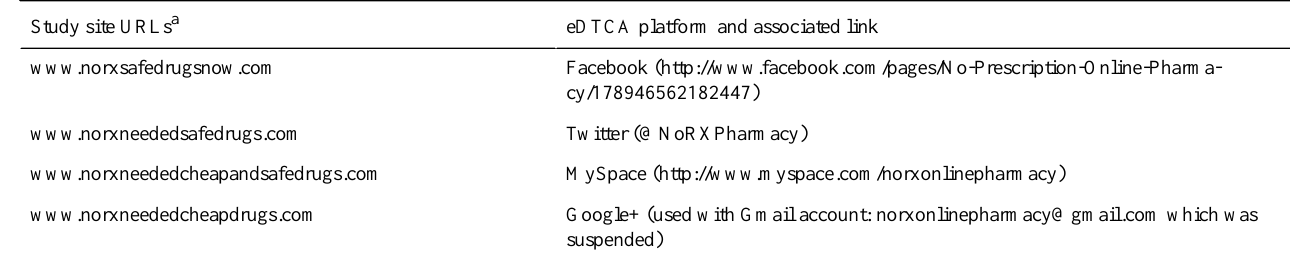
Table 1. Unique URLs linked to illicit Internet-based direct-to-consumer advertising (eDTCA) sites.